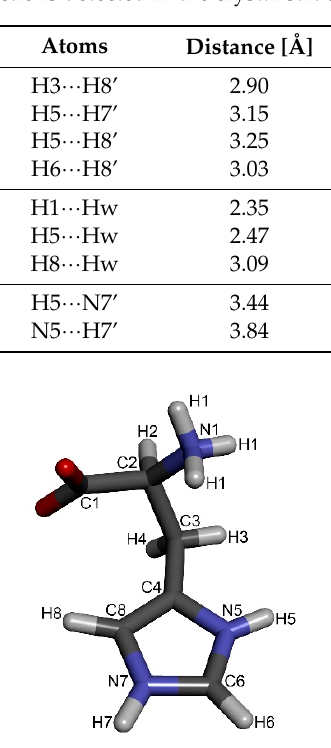
Figure 1. Molecule of L -histidine with atom numbering according to Ref. [16].